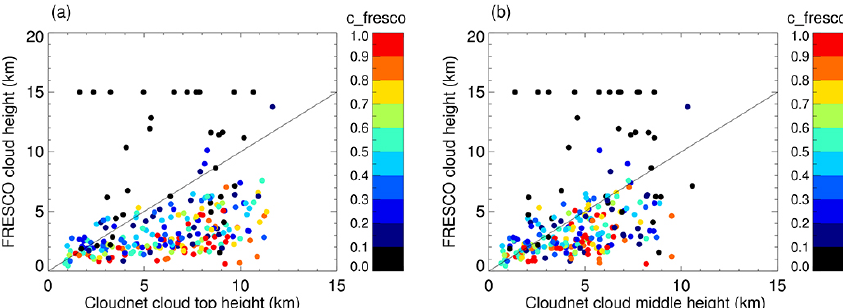
Figure 9. (a) Scatter plot of SCIAMACHY FRESCO cloud height versus Cloudnet cloud top height, for multilayer clouds. (b) Same as (a) but versus Cloudnet cloud middle height. The color of the symbol indicates the FRESCO effective cloud fraction, with the color code given by the vertical bar. The black line is the one-to-one line. For the points with c_fresco > 0.1 in (a) the correlation coefficient is 0.509 and in (b) the correlation coefficient is 0.520.